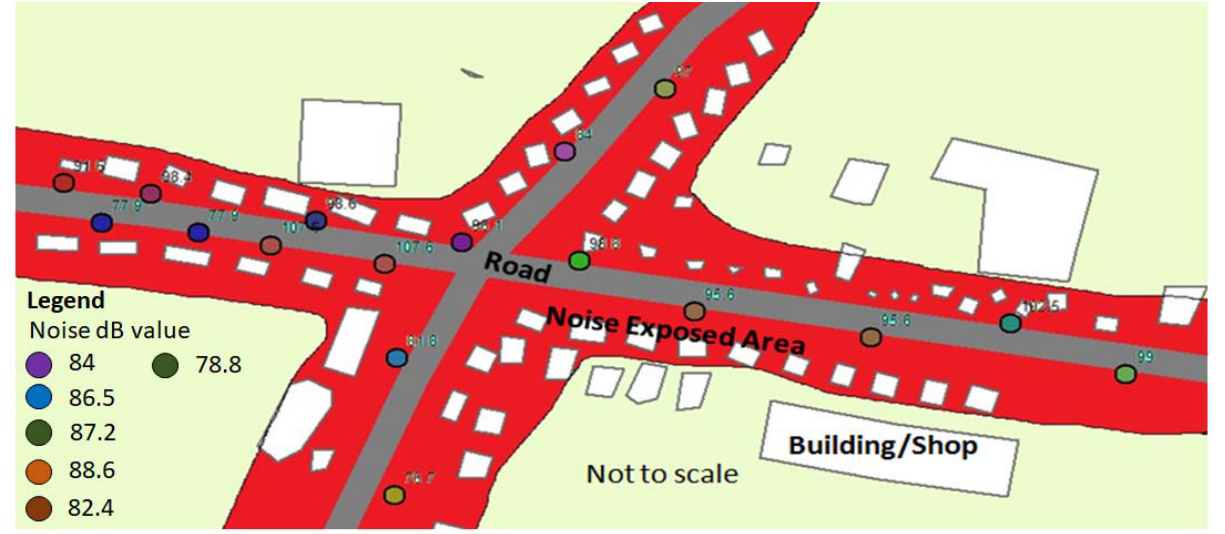
Figure 22. Noise exposures map for short duration at noise value 79.8dB in event wise at time 1– 2.30pm.